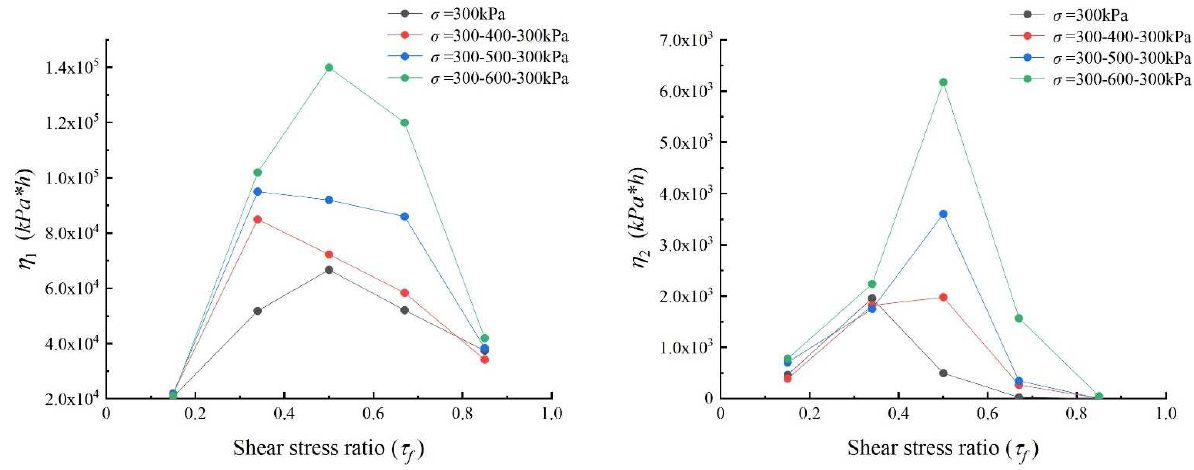
Figure 16. The curve of viscous element parameters versus shear stress under different loading am- plitude R. amplitude R